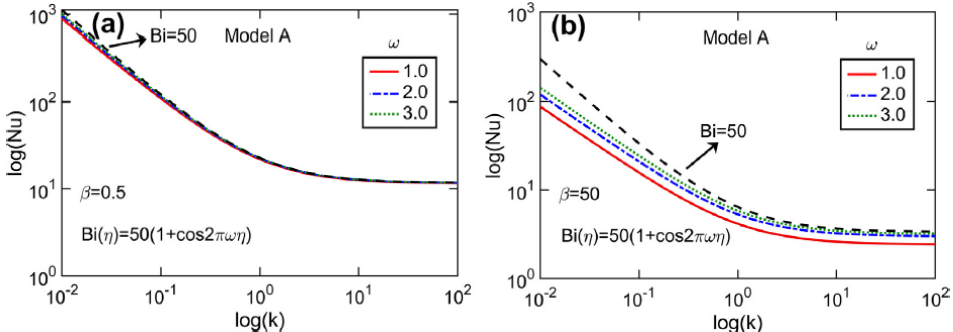
Figure 32. Distributions of Nusselt number with thermal conductivity ratio ( k ) for model ( A ), and for two interior heat generations ( a ) β = 0.5, and ( b ) β = 50, reported by Parhizi et al.